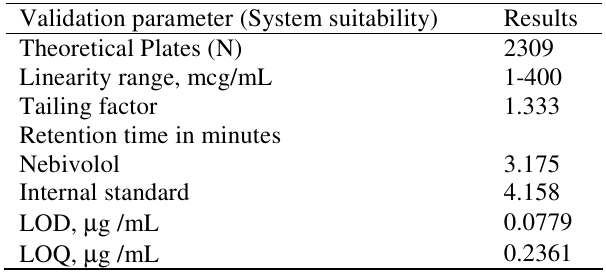
Table 3. Validation summary